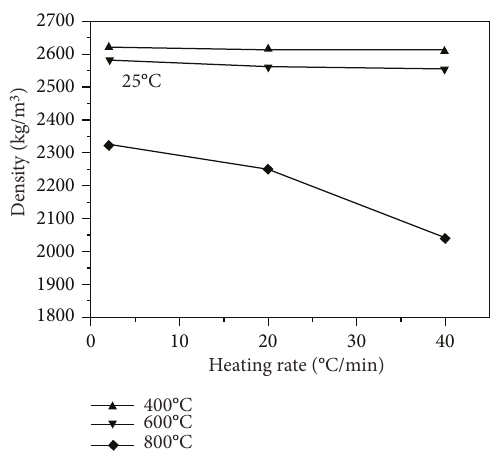
Figure 14: The correlation between density and the heating rate.